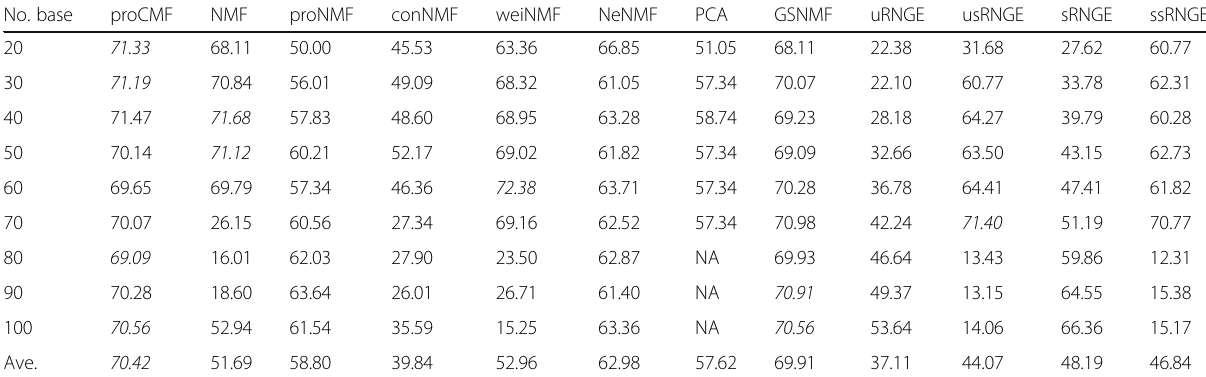
Table 3 Facial expression recognition rate (%) using the JAFFE dataset with different subspace dimensionalities (case 1: no. training = 1) No. base